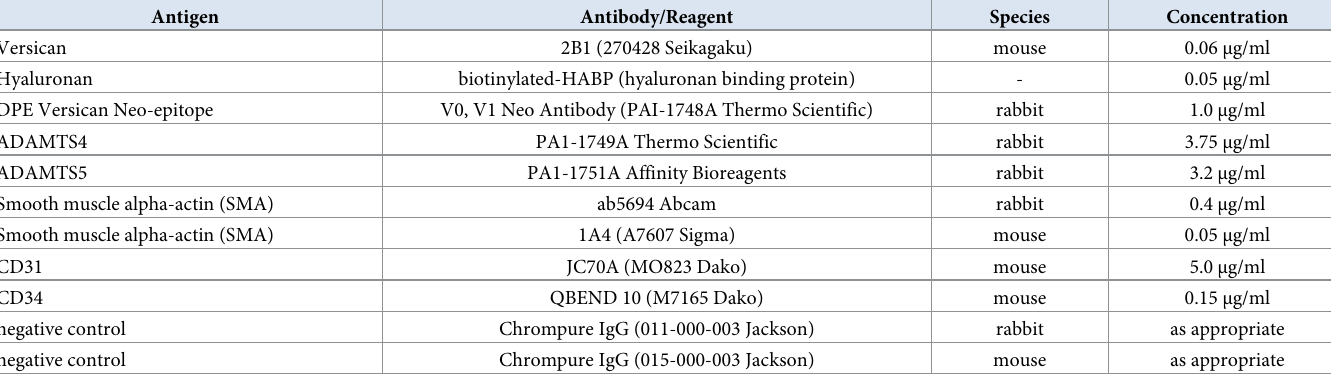
Table 2. Antibodies and reagents used in this